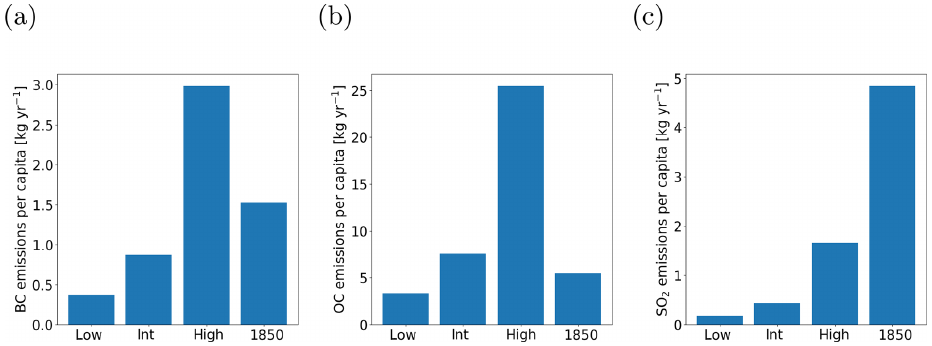
Figure 6. The same as Fig. 5 but showing per capita emissions.